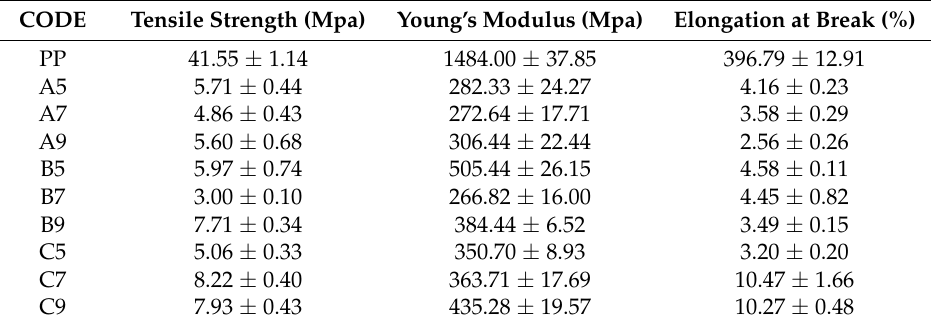
Table 3. Mechanical properties in PP/chitosan